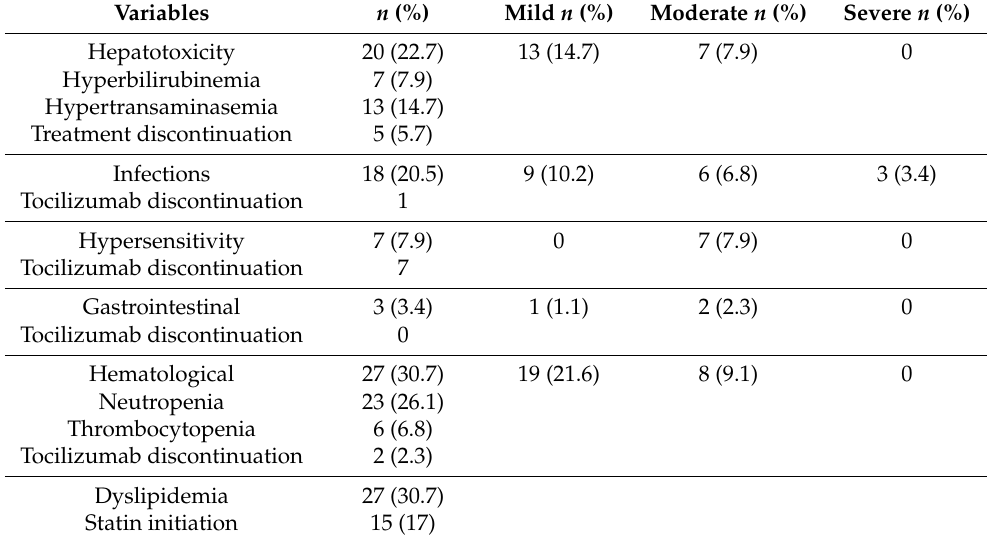
Table 3. Reported adverse events ( n =